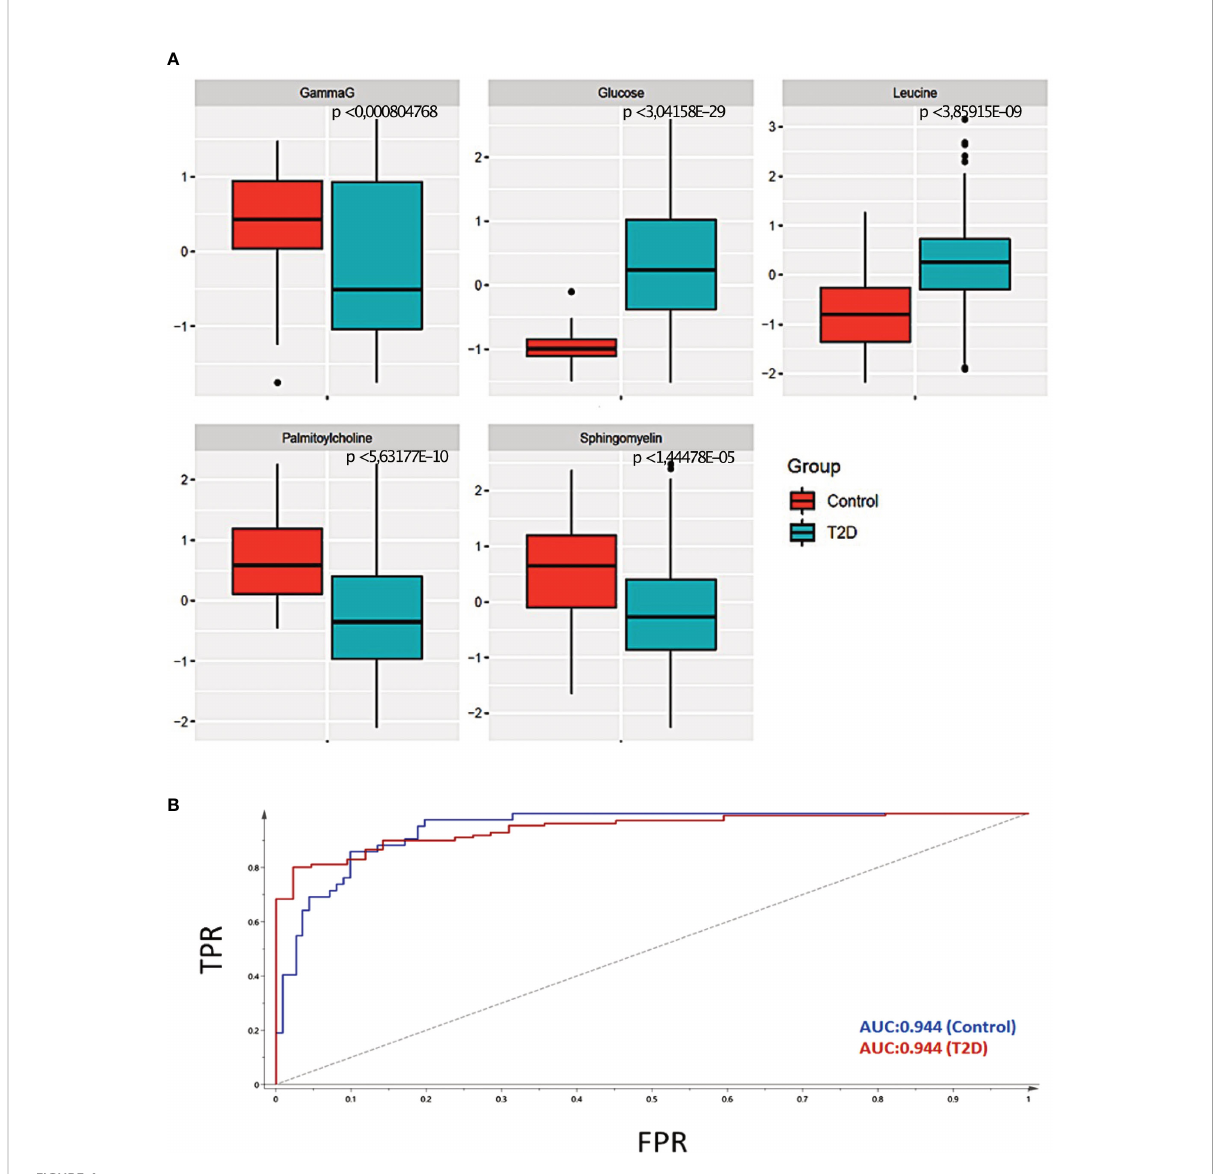
FIGURE 4 Selection of representative metabolites for data integration. (A) Statistical signi fi cance of the fi ve selected metabolites for data integration. The p-value is estimated using an unpaired t-test. The p-value < 0.05 is considered to the signi fi cant. (B) The Area Under the Curve (AUC) of the fi ve selected metabolites was 0.94, demonstrating a high accuracy of